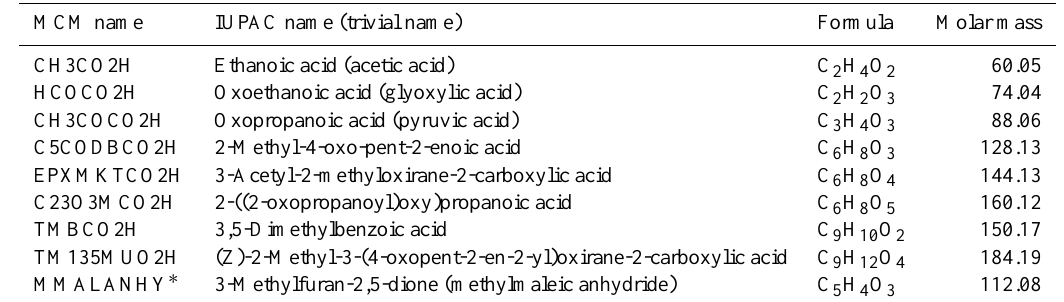
Table 3. Expected organic acids and related species from the Master Chemical Mechanism (MCM) model for the oxidation of 1,3,5- trimethylbenzene